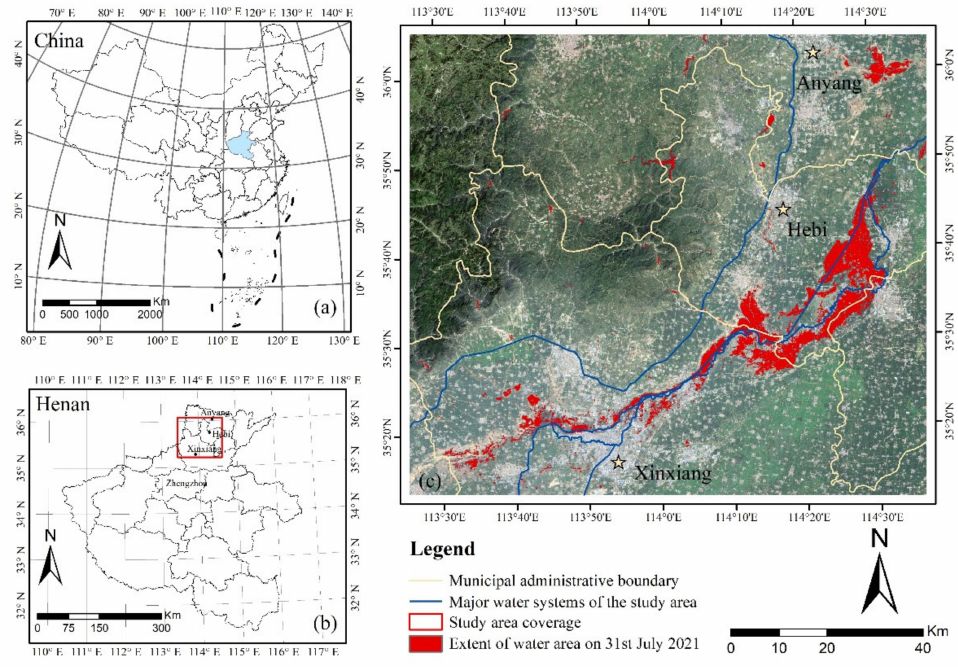
Figure 1. Location of the study area, ( a ) in China, ( b ) in Henan Province and ( c ) the Sentinel-2 imagery representing 31 July 2021 over the study area. The figure was plotted by Arcmap10.2 software. (Projection: WGS84-based Universal Transverse Mercator Zone 49N).